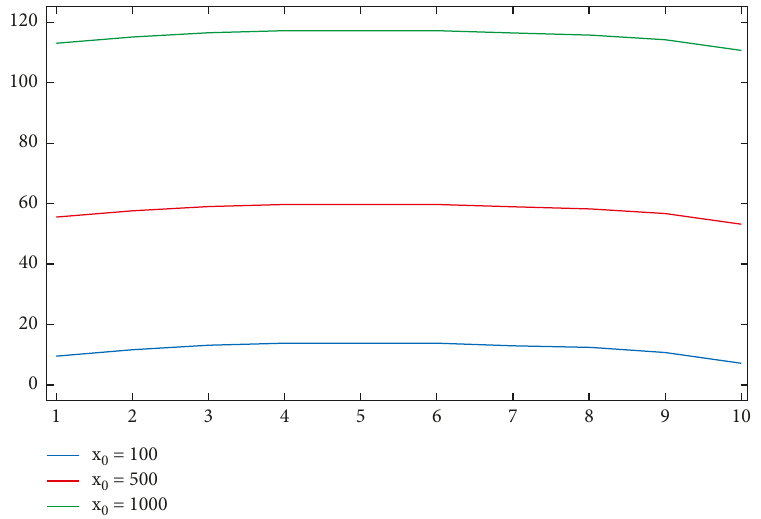
Figure 3: Absolute consumption evolution.